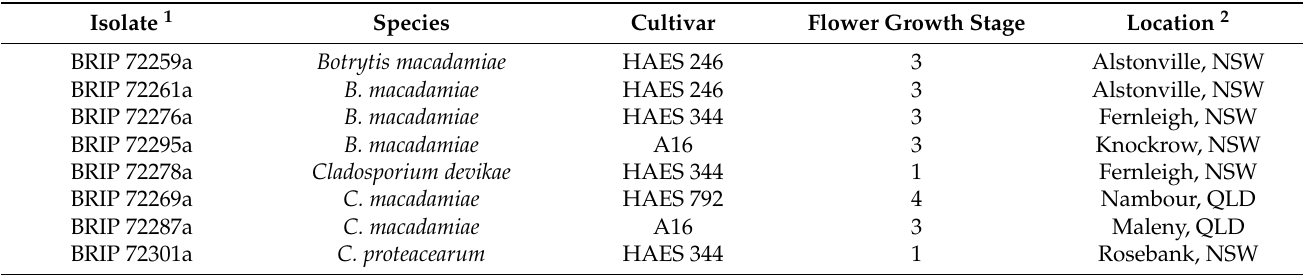
Table 1. Details of Botrytis and Cladosporium isolates obtained from macadamia racemes with flower blight symptoms included in this